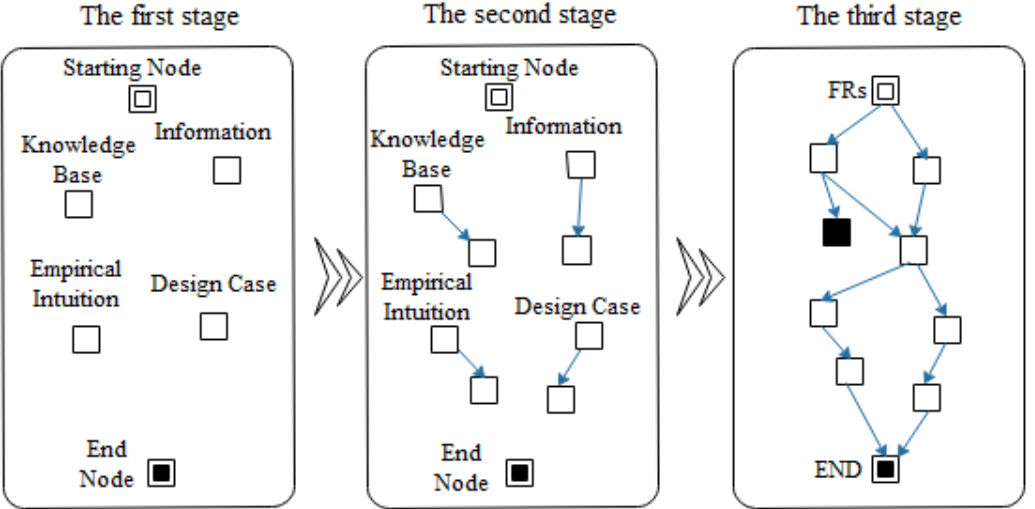
Figure 4. A three-stage product design process that considers